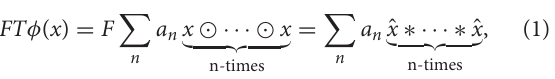
FT φ ( x ) = F TABLE 1 | Model performance (%) with and without the mask layer.